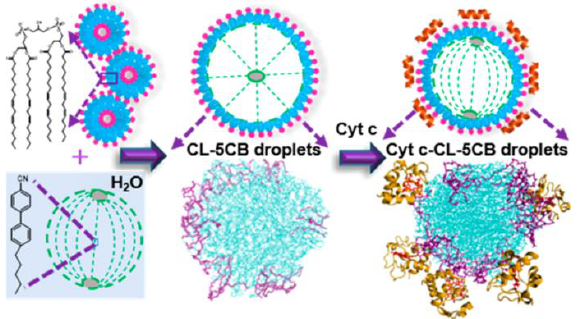
Figure 6. Schematic illustration of lipid-protein interactions that control the reorientation at the LC droplet interface. Reprinted with permission from ref. [109]. Copyright 2021 American Chemical Society.